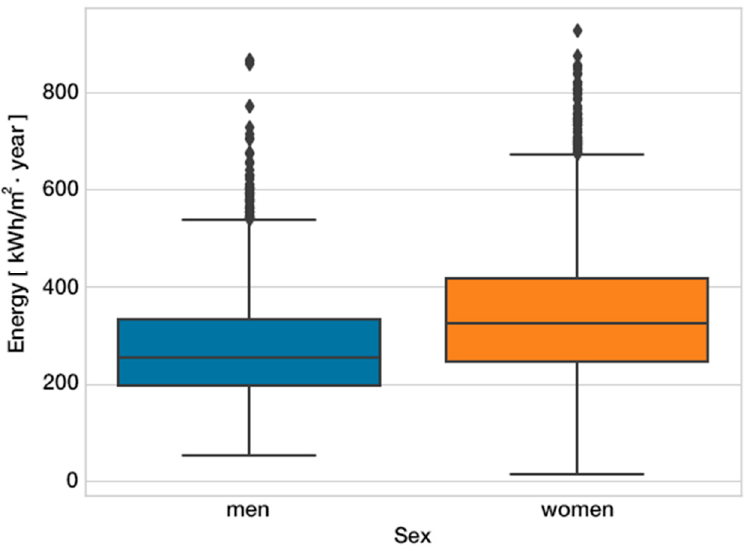
Figure 8. Comparison of energy consumption by sex.